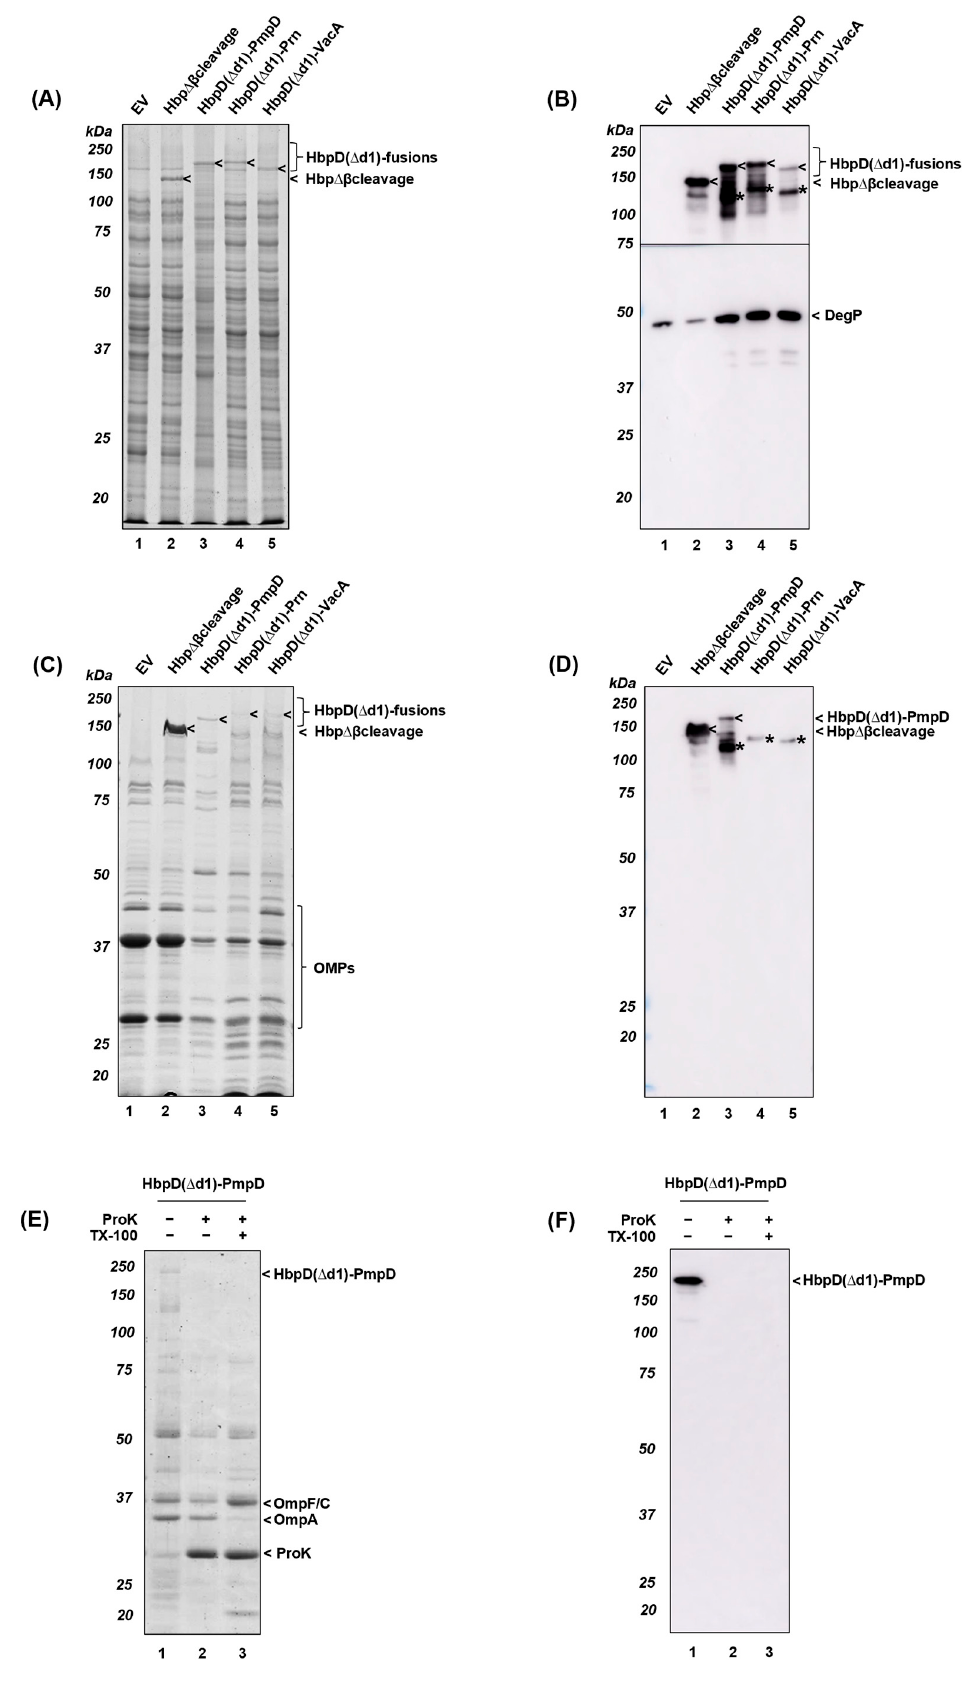
Figure 4. Expression of EV, Hbp ∆ β cleavage, HbpD( ∆ d1)-PmpD, HbpD( ∆ d1)-Prn and HbpD( ∆